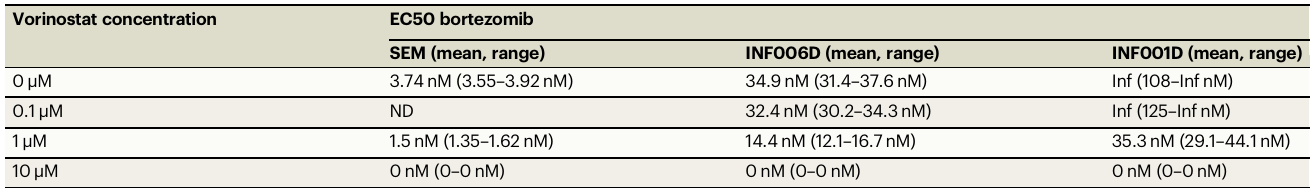
Table 1 | Vorinostat and bortezomib combinatorial treatment Vorinostat concentration EC50 bortezomib SEM (mean, range) INF006D (mean, range) INF001D (mean, range)